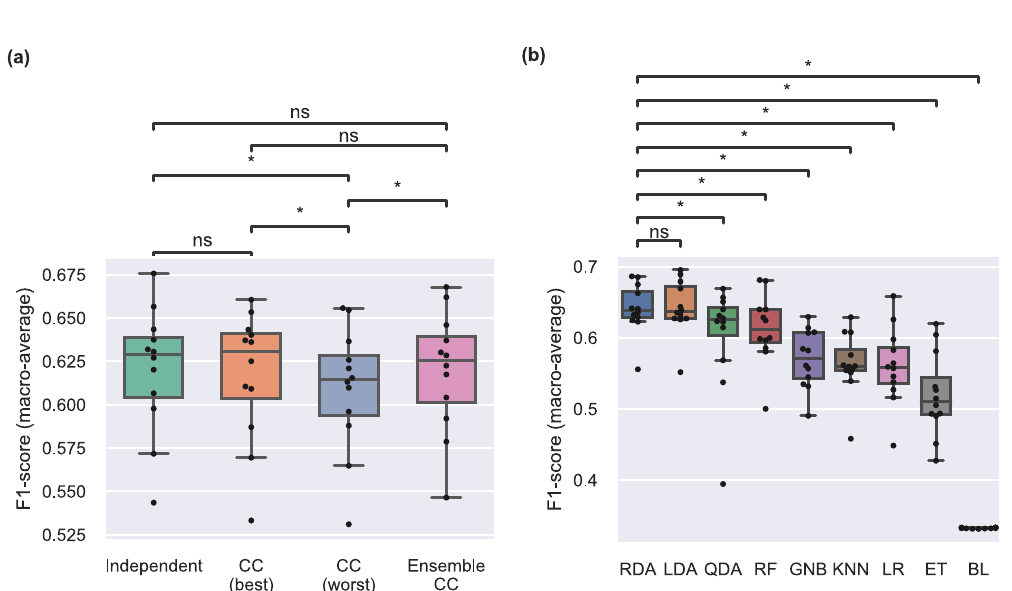
Figure 3. Performance comparisons. ( a ) Comparison of multi-output classification strategies using an LDA base classifier. CC best and CC worst correspond to best- and worst-performing single CC models, respectively. For each participant, 100 random chains were generated and evaluated. Ensemble CC corresponds to a model with 10 random chains. Straight lines, medians; solid boxes, interquartile ranges; whiskers, overall ranges of non-outlier data; dots, individual data points ( n = 12 ); asterisk, p < 0.05 ; n.s., p > 0.05 . ( b ) Comparison of classification algorithms using F1-score and the independent multi-output strategy. Classifiers are presented in order of decreasing median performance and statistical comparisons are performed only against the highest- performing algorithm. CC classifier chain, RDA regularised discriminant analysis, LDA linear discriminant analysis, QDA quadratic discriminant analysis, RF random forest, GNB Gaussian naive Bayes, KNN k-nearest neighbours, LR logistic regression, ET extra trees, BL